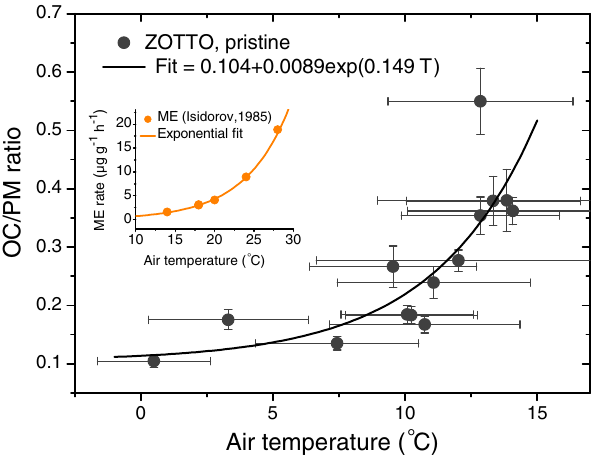
Figure 15. OC / PM ratios in PM 10 for pristine conditions vs. aver- aged ground-level temperature ( ± SD) estimated from the meteoro- logical profiles along each trajectory. The coefficient of determina- tion of the fit ( R 2 ) is 0.66. The insert shows monoterpene emission (ME) rate from Scots pine vs. temperature (Isidorov et al., 1985) and the exponential fit: ME rate = 0.121 · exp [ 0 . 179 · T ( ◦ C)] with R 2 =